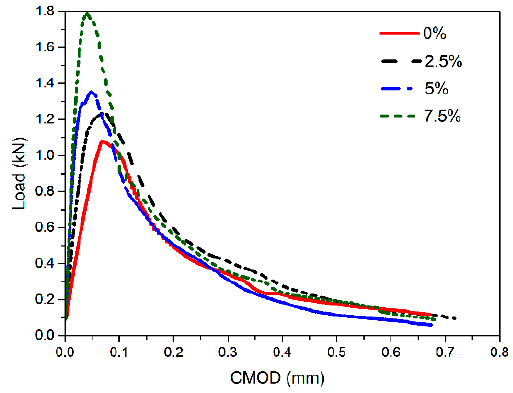
Figure 7. Load- crack mouth opening displacement (CMOD) curves of FAGC with different CAC CAC contents.